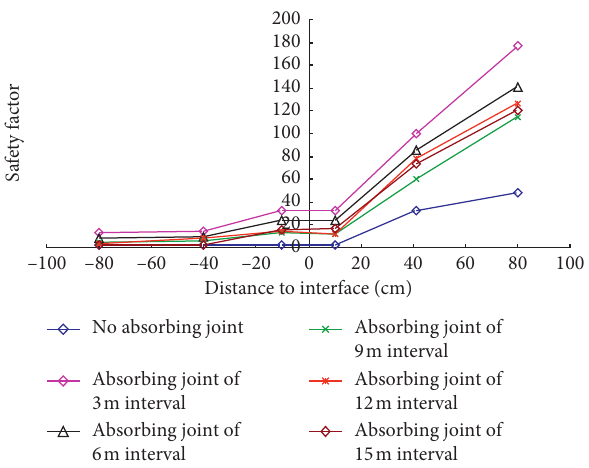
Figure 14: Safety factor of tunnel vault at each monitoring section.